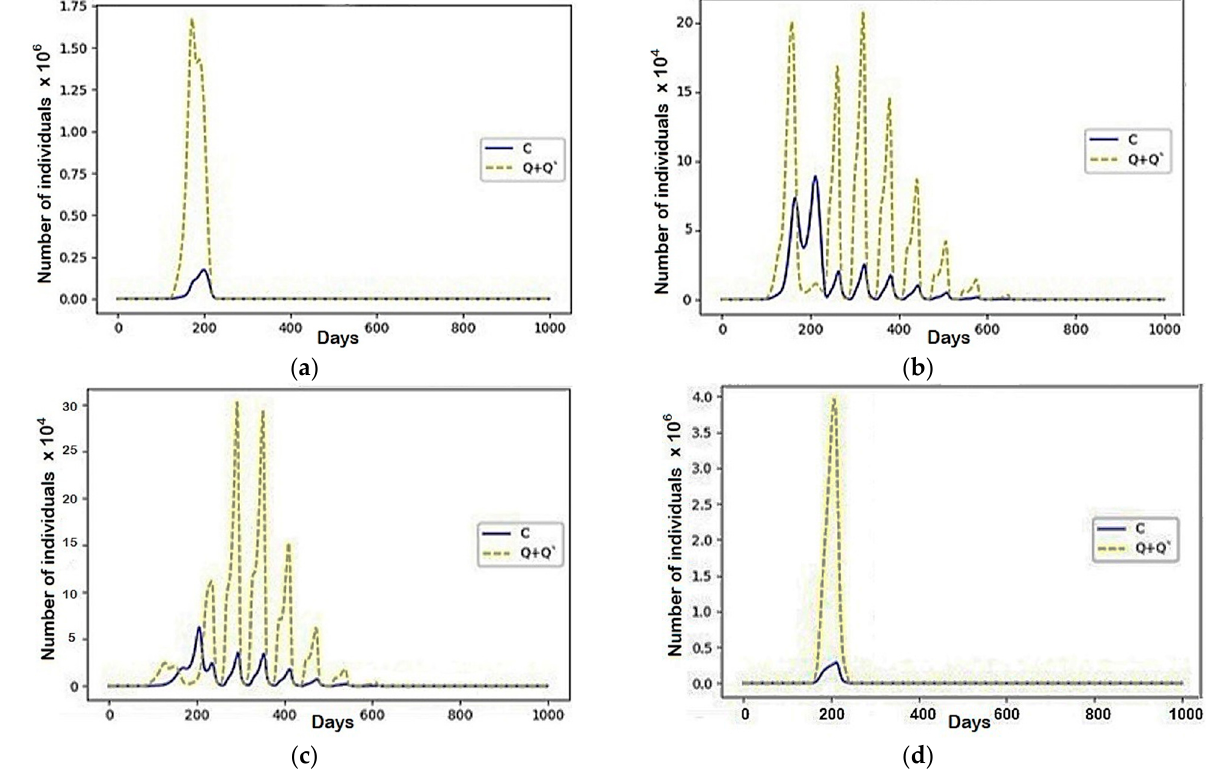
Figure 8. A scenario in which 𝑎 (cid:2869) = 1, 𝑏 (cid:2869) = −0.1, 𝑏 (cid:2872) = 0.05, 𝑐 (cid:2869) = −0.15, 𝑐 (cid:2872) = 0.1, 𝑑 (cid:2869) = −0.3,𝑑 (cid:2870) = −0.7 , and the rest are equal to zero: ( a ) Region 1; ( b ) Region 2; ( c ) Region 3; ( d ) Region 4.